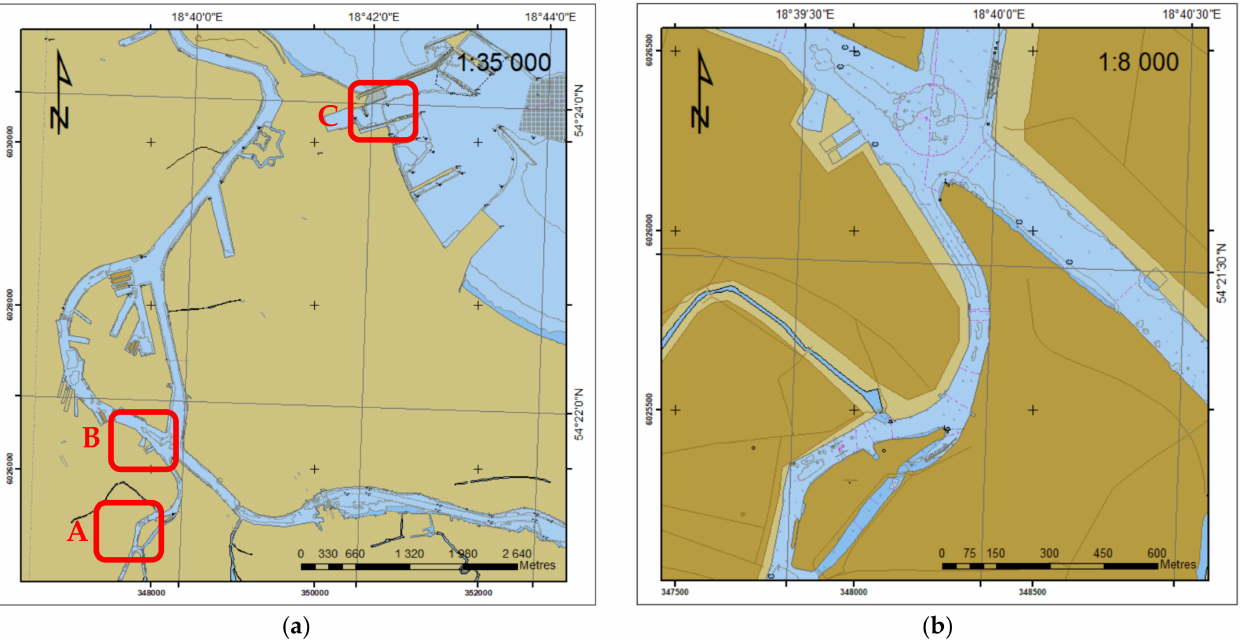
Figure 4. Location of measurements of the sound speed in water in Gda´nsk ( a ): Motława River (A), Martwa Wisła River (B) and water station in Gda´nsk Northern Port (C); Motława River ( b ). Time courses of water basic parameters: temperature and salinity are presented in Figure 5. A three-day range of changes of these parameters is not high, and it varies in the range of ∆ t = 1.5 ◦ C and ∆ S = 0.5 psu. A value of S = 6 psu has been set to determine the sound velocity in